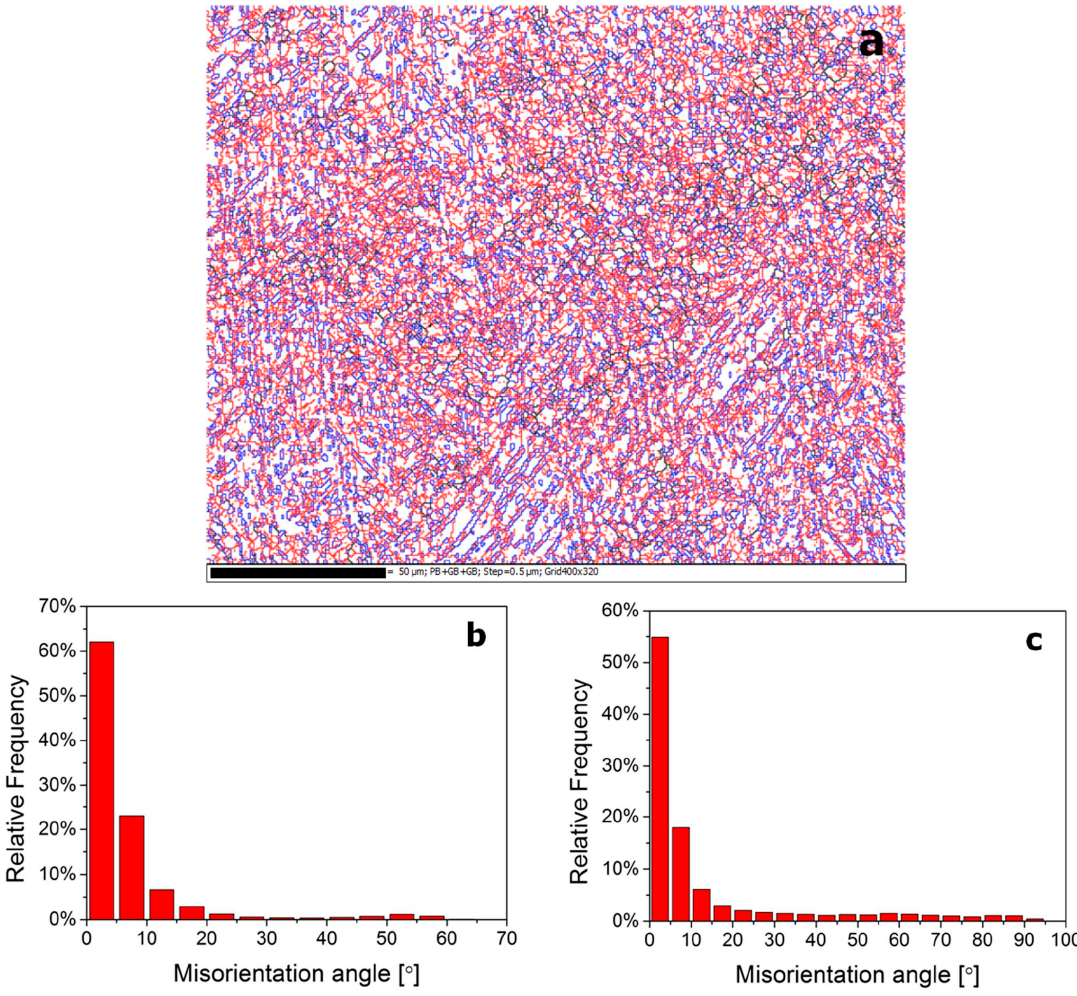
Figure 8. EBSD grain boundary map ( a ) and corresponding misorientation distributions of the hot-rolled β 20C alloy in β ( b ) and α ( c ) phases. hot-rolled β 20C alloy in β ( b ) and α ( c )